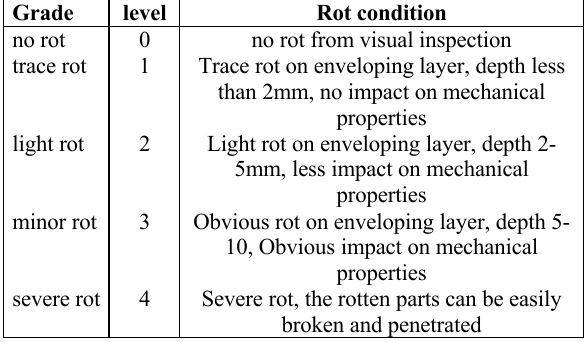
Table 2 . Rot grade of wood components on enveloping layer.